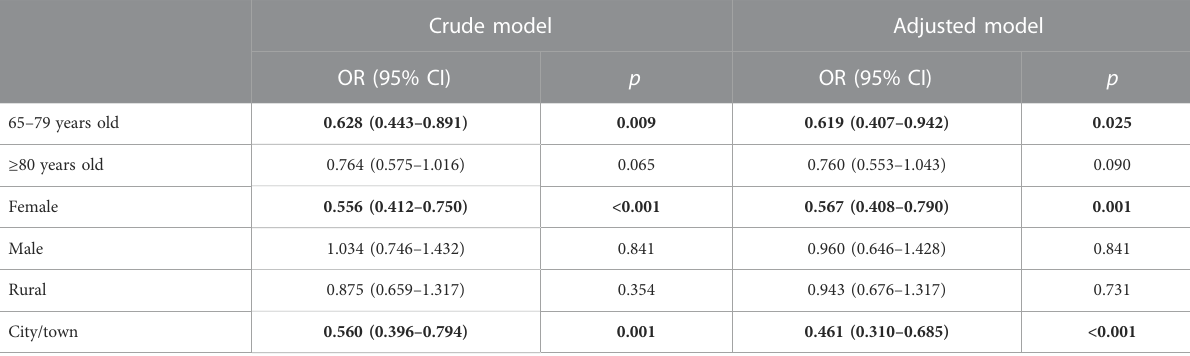
TABLE 3 Associations between CC decline and LA by subgroup